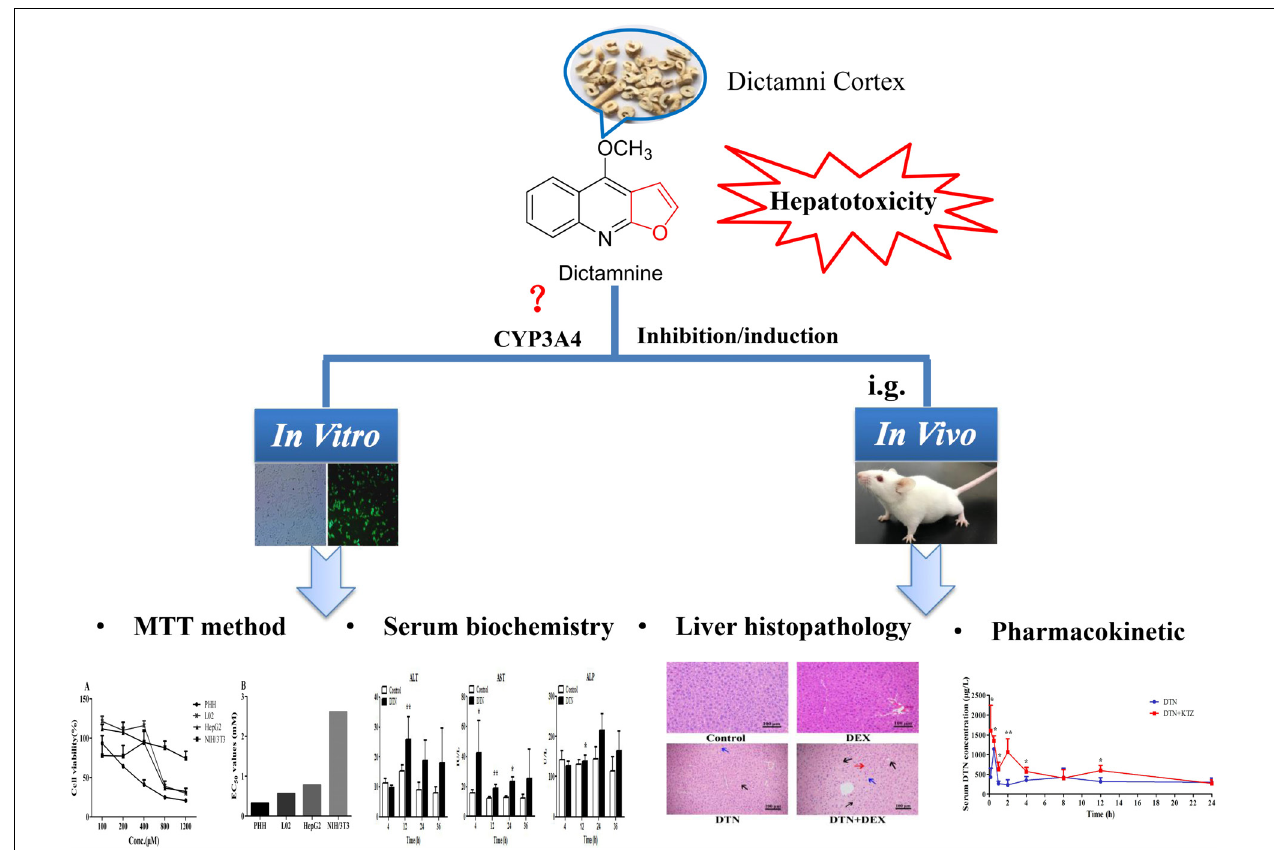
FIGURE 2 | Scheme for the study. ∗ p < 0.05, ∗∗ p < 0.01 vs. control